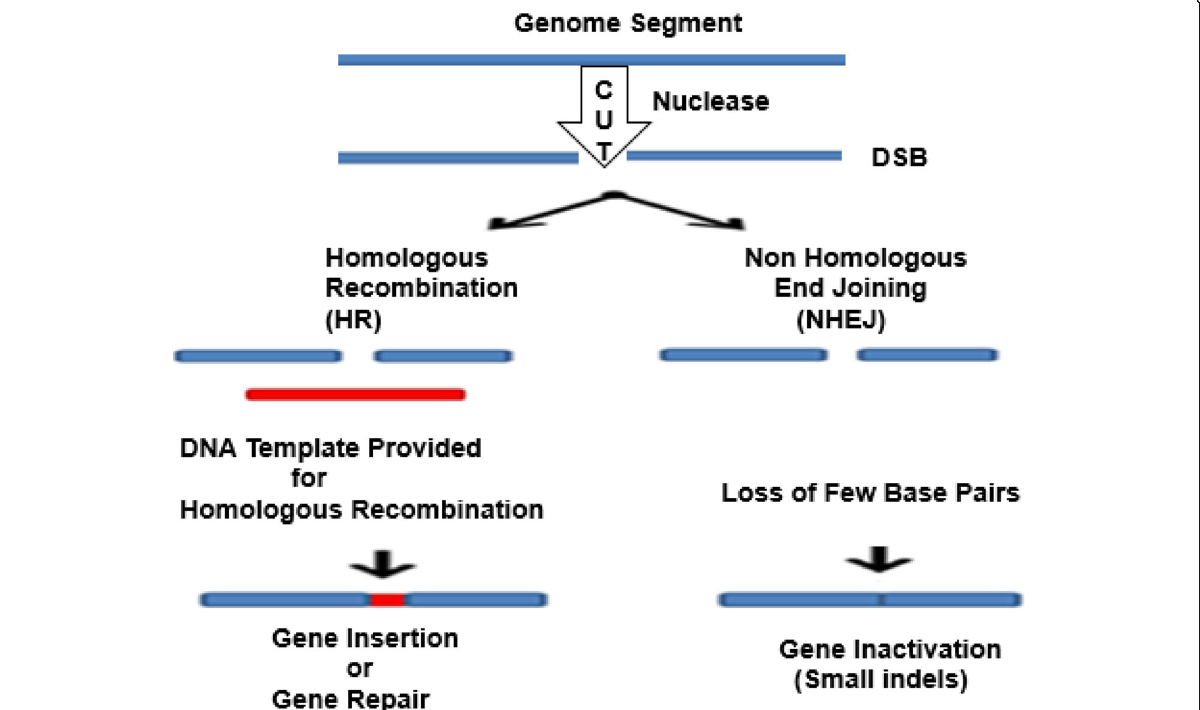
Fig. 1 Genome editing outcomes. Genome editing nucleases induce double-strand breaks (DSBs). The breaks are repaired through two ways: by non-homologous end joining (NHEJ) in the absence of a donor template or via homologous recombination (HR) in the presence of a donor template. The NHEJ creates few base insertions or deletion, resulting in an indel, or in frameshift that causes gene disruption. In the HR pathway, a donor DNA (a plasmid or single-stranded oligonucleotide) can be integrated to the target site to modify the gene, introducing the nucleotides and leading to insertion of cDNA or frameshifts induction. (Adapted from